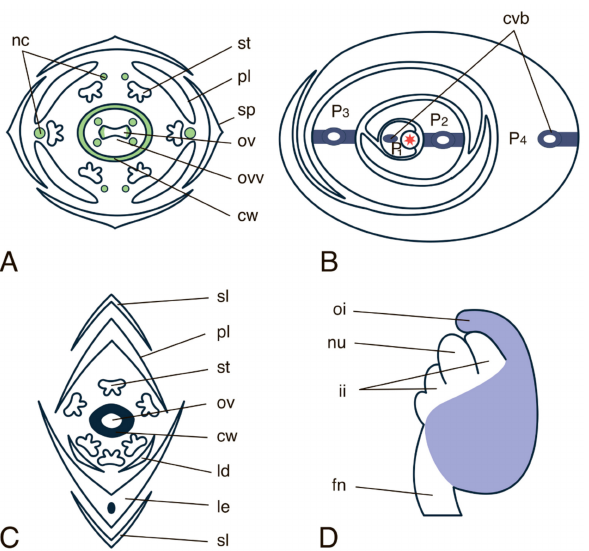
Figure 5. Expression pattern of the “reproductive” YABBY ” group. ( A – C ) Expression of CRC subfamily, ( D ) expression of INO subfamily. ( A ) Flower diagram of A. thaliana . ( B ) Line drawing of cross section through vegetative apex of O. sativa . ( C ) Flower diagram of O. sativa . ( D ) Ovule of A. thaliana . Schemes are based on descriptions and photos of in situ RNA-RNA hybridizations from [12,19,60,64,97,98]. cvb—central vascular bundle, nc—nectary, oi—outer integument, ii—inner integument, nu—nucellus, fn—funiculus, asterisk in ( B ) marks the